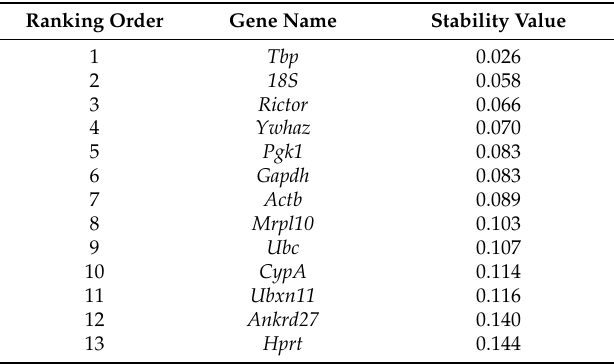
Table 4. NormFinder determined stability values of candidate housekeeping genes in DRG samples. Stability values of tested housekeeping genes were calculated by NormFinder software and then ranked. The lower the stability value, the higher the gene